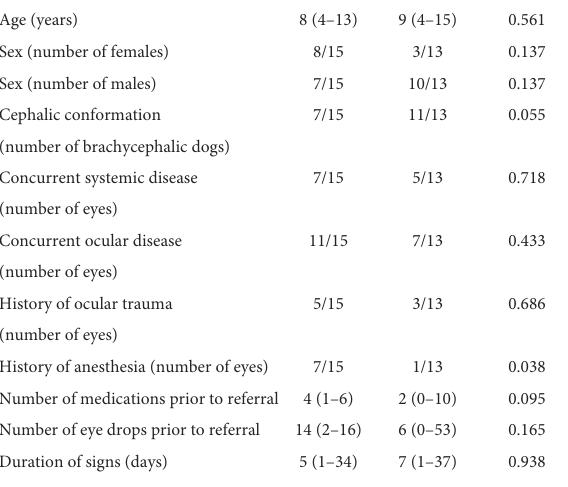
TABLE 2 Summary of clinical findings from 28 canine patients and associated corneal ulcers infected with Staphylococcus pseudintermedius .